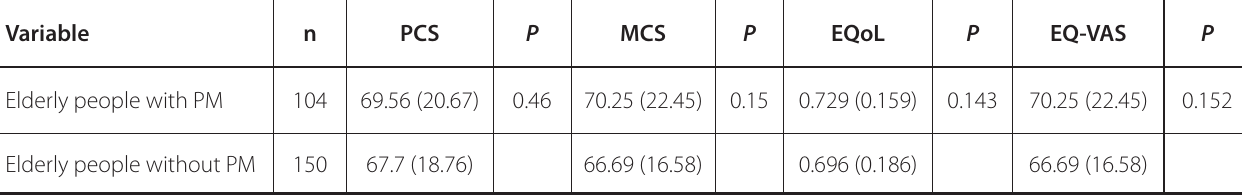
Table 7 . Average scores and standard deviations of the SF-36 and EQ-5D.